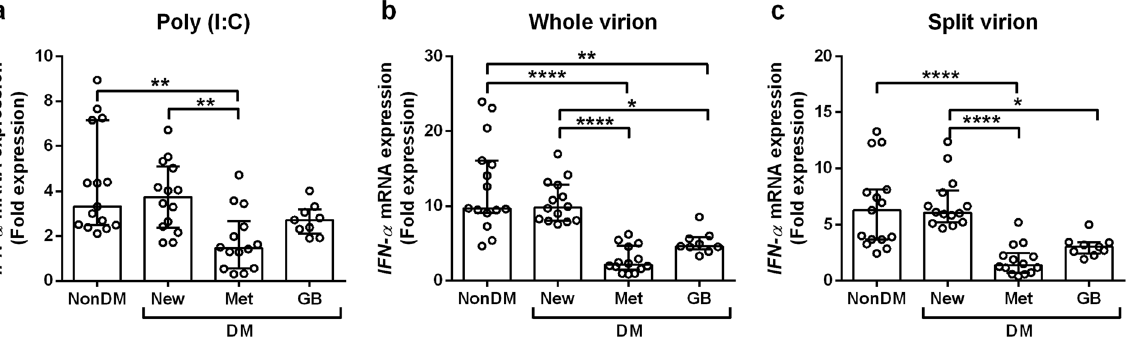
Figure 3. Metformin- and glibenclamide-treated DM reduced IFN- α expression upon stimulation with whole- and split-virion influenza vaccines. IFN- α expression was determined in whole-blood samples after 3-h stimulation in vitro with ( a ) poly I:C, ( b ) influenza virus (influenza whole-virion, X31), or ( c ) influenza vaccine (influenza split-virion) before RNA extraction for measurement of IFNA1 mRNA expression by real-time PCR. Expression is shown as fold expression with respect to the medium control and normalized to that of GAPDH . Each point represents an individual (non-DM; n = 15), (new-DM; n = 14), (Met-DM; n = 14), or (GB-DM; n = 9). Statistical analyses were performed using one-way ANOVA. Horizontal lines represent the median and interquartile range. * p < 0.05; ** p < 0.01; **** p <